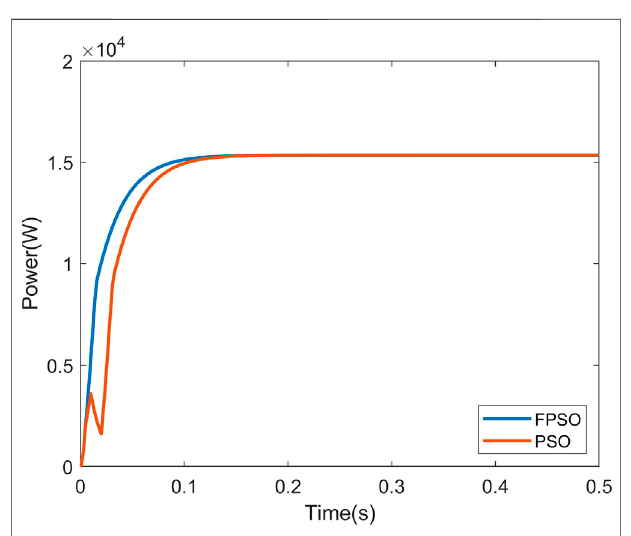
FIGURE 10 | Startup response of the fuzzy adaptive PSO and the convential PSO MPPT for irridiation 3.